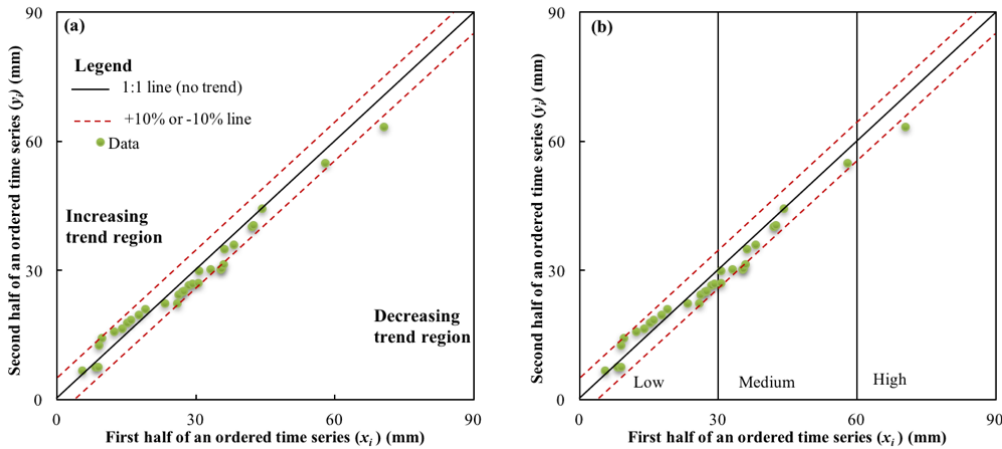
Figure 2. Example of the innovative trend analysis (ITA) method proposed by Şen [26]. ( a ) non- monotonic trends and ( b ) the trends of each cluster (low, medium and